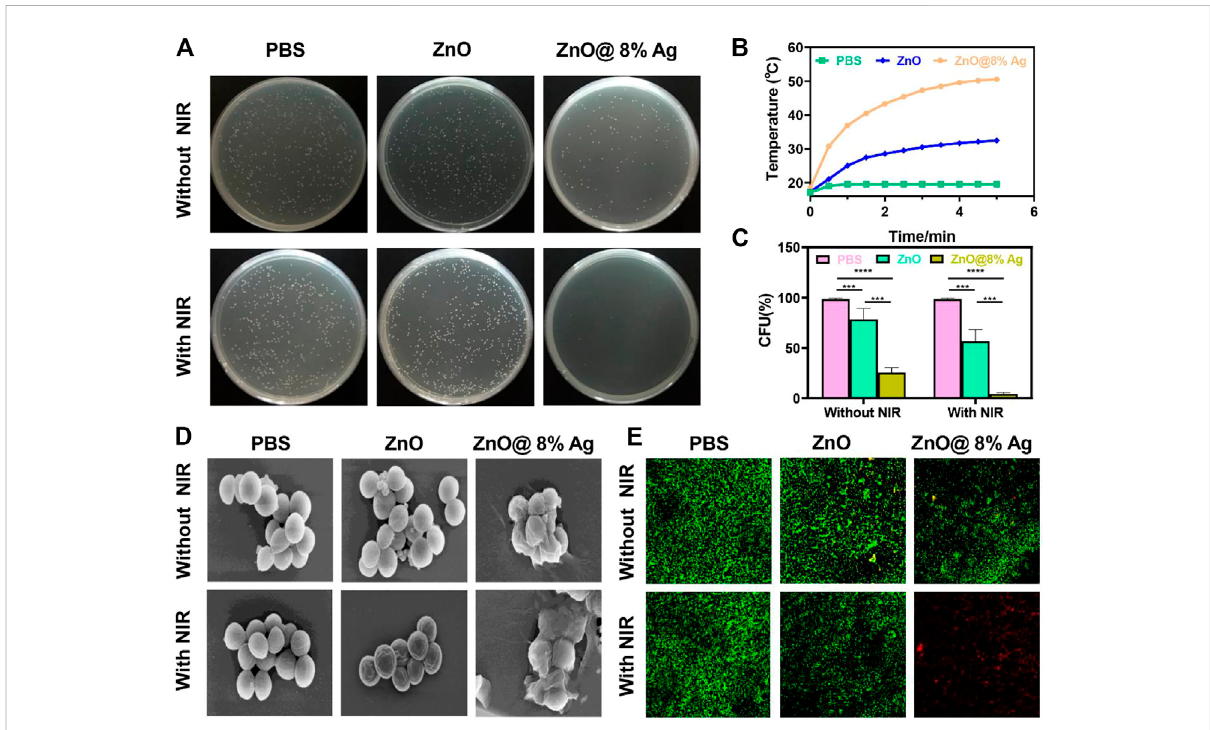
FIGURE 4 In vitro antibacterial activity of ZnO@8%Ag. (A) Bactericidal effect of PBS, ZnO, and ZnO@8%Ag against S. aureus with/without NIR irradiation (808 nm, 2 W/cm 2 , 10 min), (B) temperature elevation curve corresponding to (A) , (C) survival rate of S. aureus corresponding to (B) ** p < 0.01, (D) SEM images of S. aureus treated with PBS, ZnO, and ZnO@8%Ag under NIR irradiation (808 nm, 2 W/cm 2 , 10 min), and (E) live/dead staining assay of S. aureus corresponding to (D)